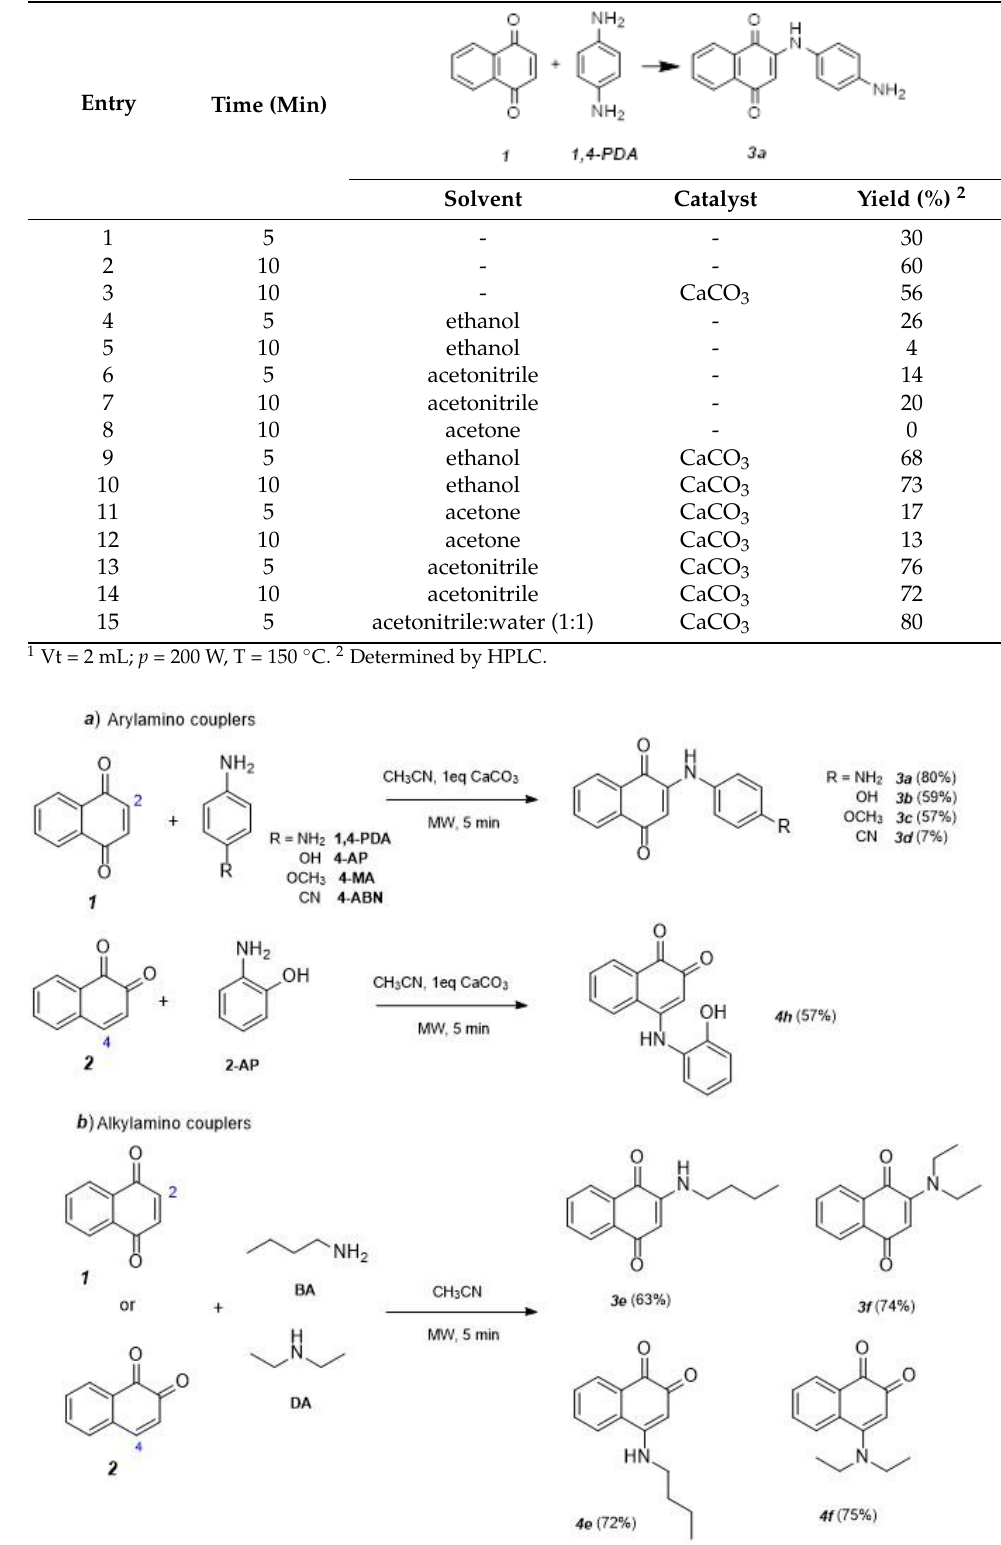
Table 1. Reactions yields for the synthesis of 3a from 1,4-NQ and 1,4-PDA 1 .